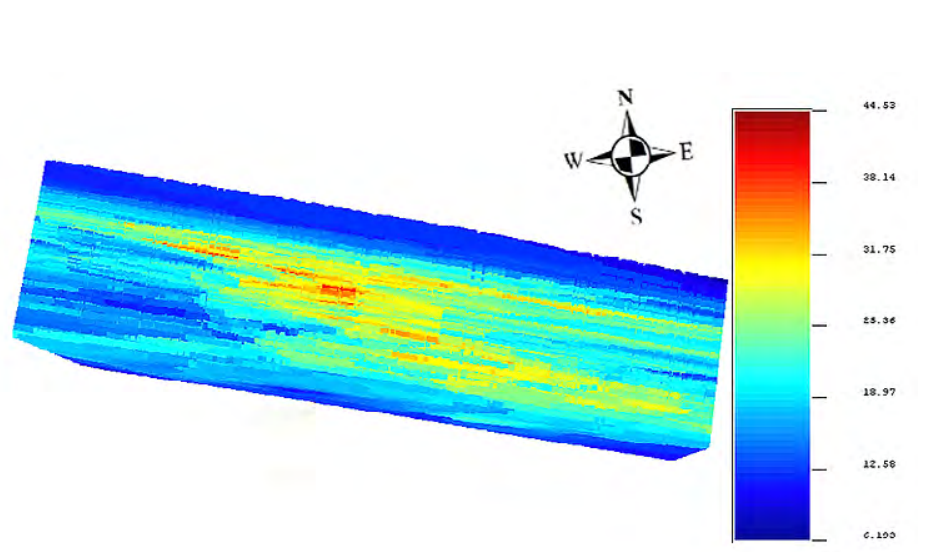
Figure 11c. SP P90